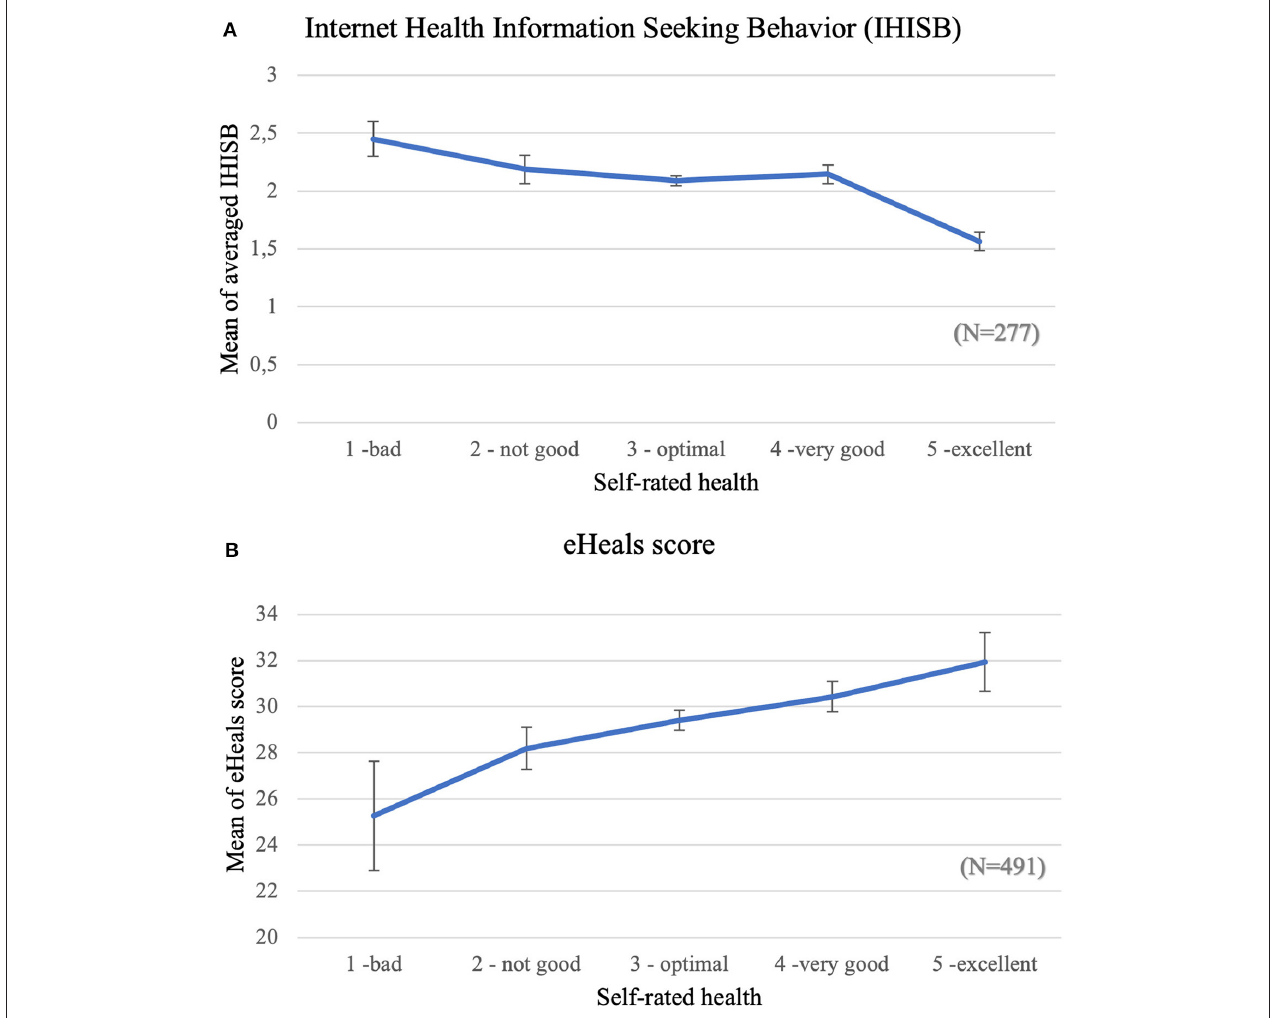
FIGURE 1 | The distribution of (A) IHISB (a composite score of Internet Health Information Seeking Behavior) and (B) eHEALS values across self-rated health categories.